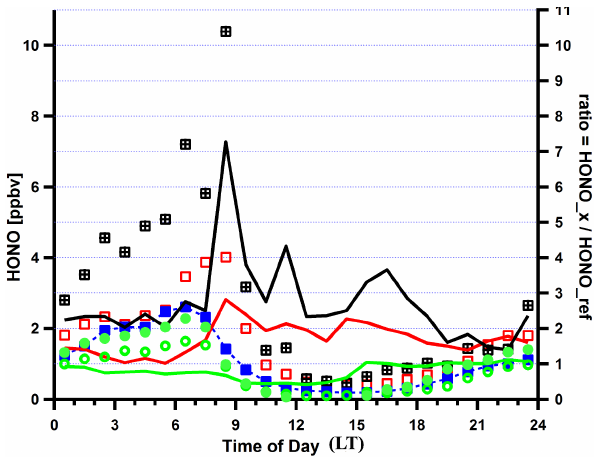
Fig. 2. Comparison of HONO measurements from three LP- DOAS instruments during two field campaigns in the MCMA. (open circles) HONO mean concentration during MCMA-2003 from DOAS#2 at 70m above ground; (solid circles) MCMA-2003 mean from DOAS#1 at 18m above ground; (solid squares with dashed line) reference case: MCMA-2006 mean, excluding data from the model period (24–29 Apri), data measured 16m above ground; (open squares) mean during the model period (24–29 April); (crossed squares) data from 29 April 2006. Also shown on the right scale are ratios of HONO concentrations for data sub- sets: (green line) MCMA-2003 average of two DOAS instruments, divided by reference case; (red line) model period divided by refer- ence case; (black line) 29 April 2006 divided by the reference